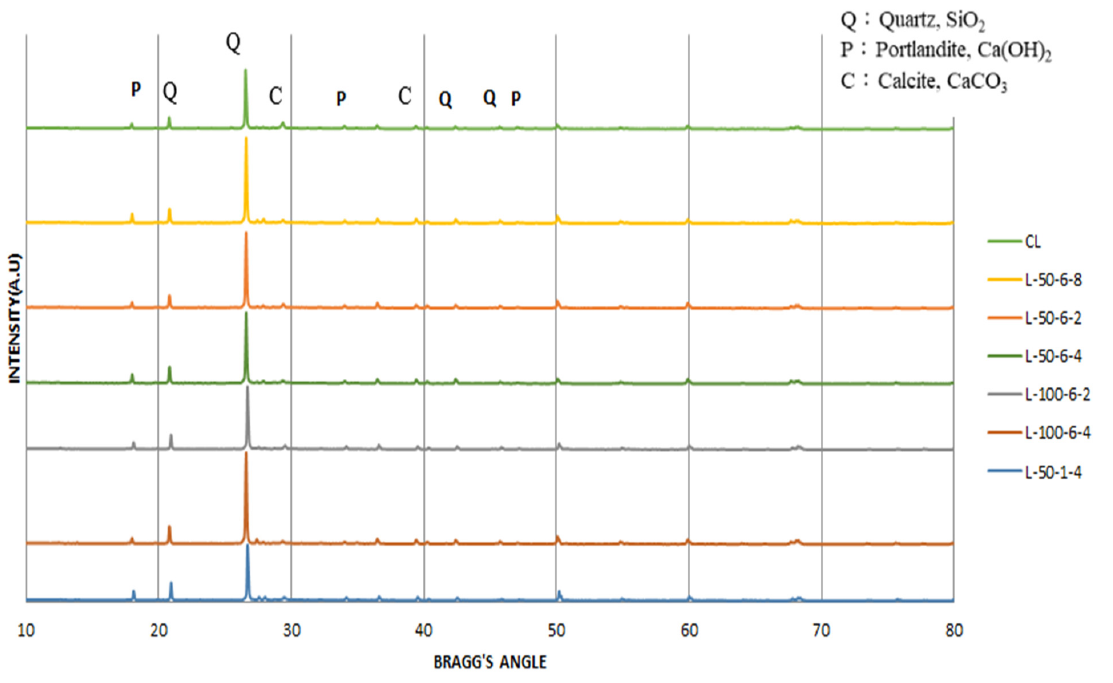
Figure 11. XRD profiles for the specimens at 90-day water or CO 2 curing (Q: Quartz, SiO 2 ; P: Portlandite, Ca(OH) 2 ; C: Calcite, CaCO 3 ). Portlandite, Ca(OH) 2 ; C: Calcite, CaCO 3